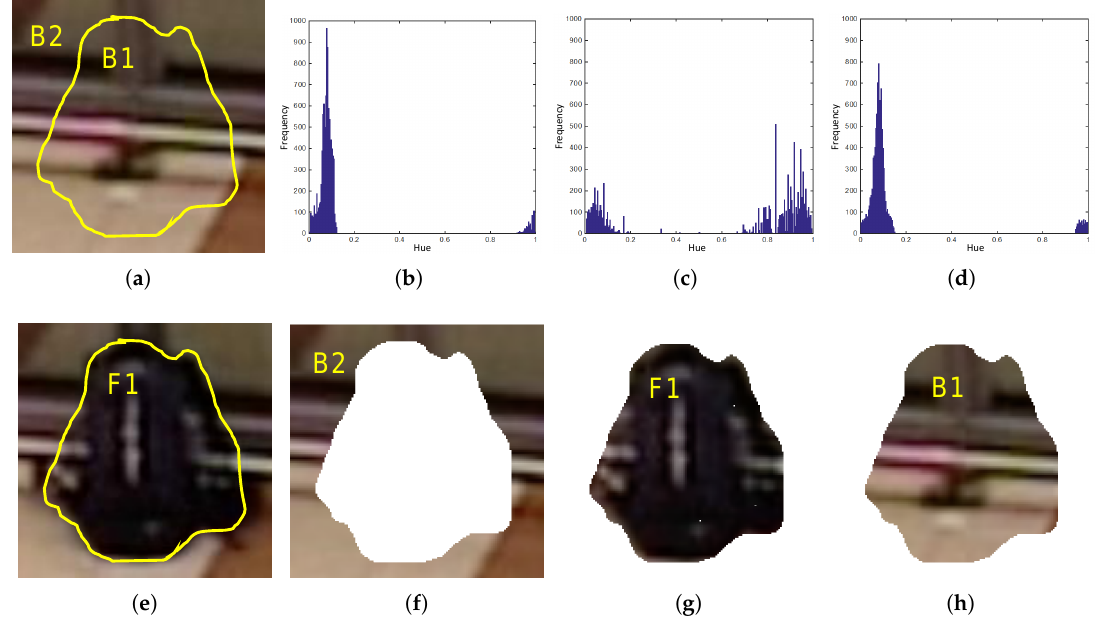
Figure 8. Example of Pixel Color Contrast algorithm operation. Subfigure ( a ) shows initial frame and ( e ) depicts an abandoned bag in a posterior frame. PCC computes Hue histograms, ( b – d ), from B2 ( f ) , F1 ( g ) and B1 ( h ), respectively. Histogram comparisons ( b , c ) and ( c , d ) are made and final abandoned decision is taken from the results. Since ( b ) is more similar to ( d ) than to ( c ), this means ( e ) represents an abandoned